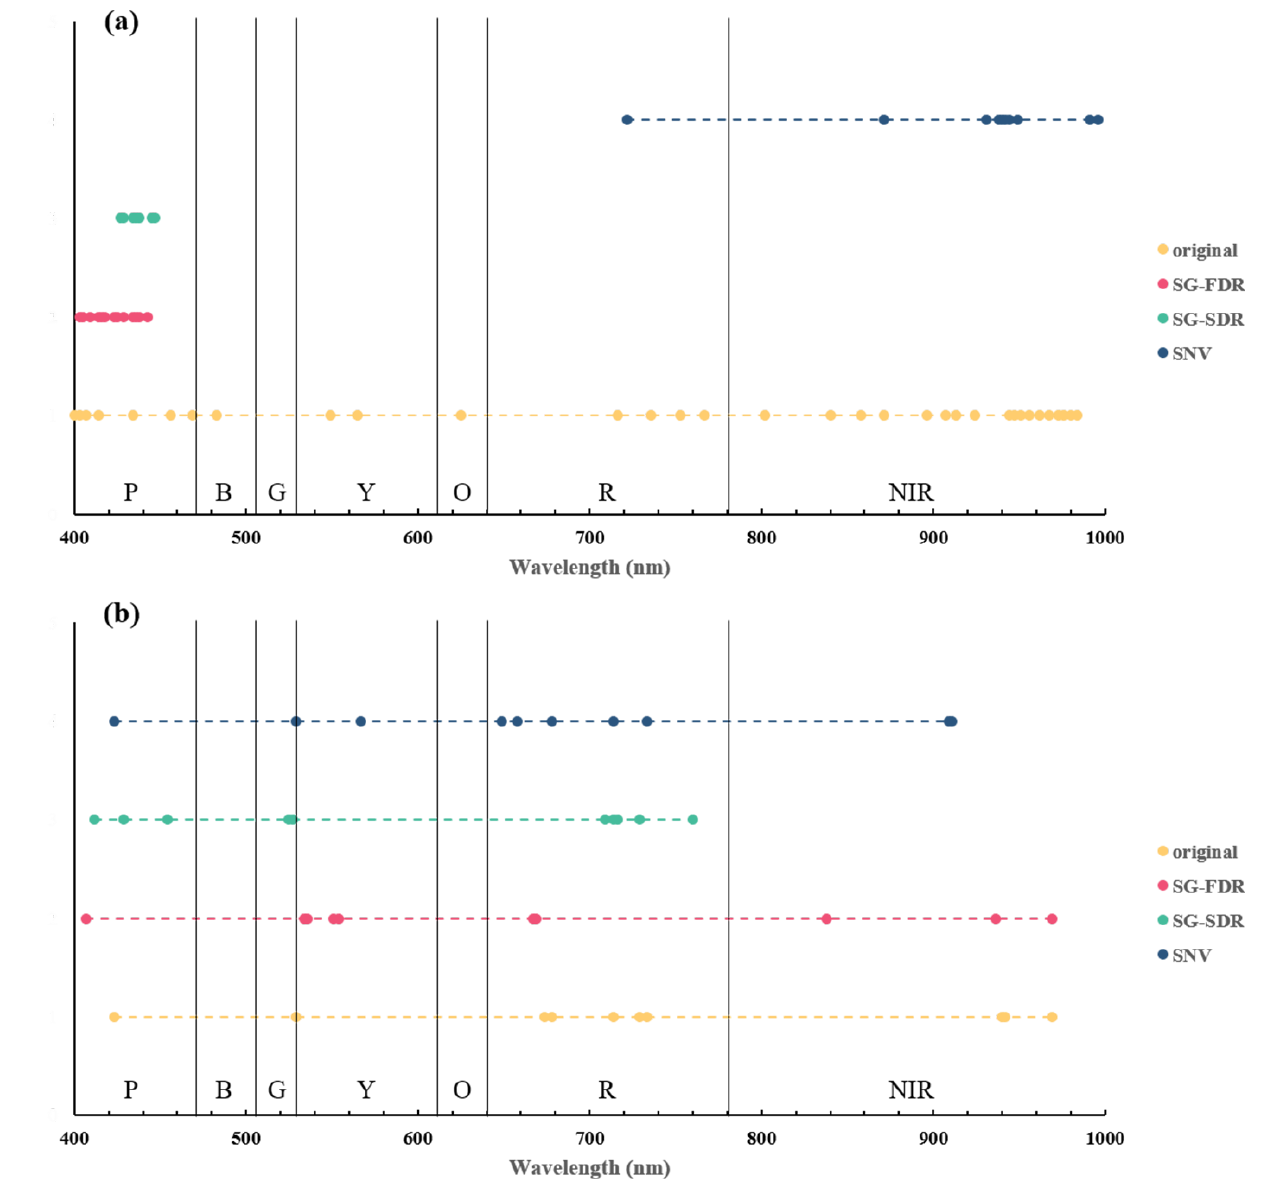
Figure 5. Screening results: ( a ) SPA and ( b ) SFLA.